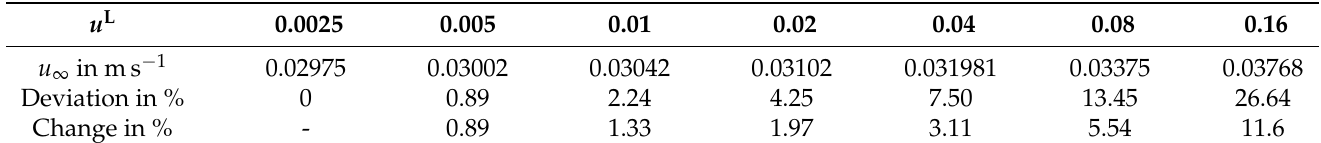
Figure 4. Drag coefficient of correlations discussed in Section 2.1 along with the simulation results plotted against the Reynolds number, computed using the maximum settling velocity measured in the simulation. Table 7. Maximum settling velocity for µ f = 0.005kgm − 1 s − 1 for a chosen lattice velocity u L (see Equation (27)). Addition- ally, given is the deviation to the velocity obtained with u L = 0.0025 and the change of maximum velocity to the value obtained with the next smaller u L .